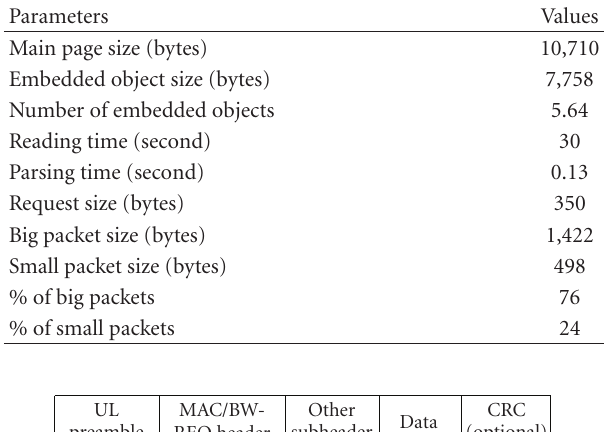
Table 7: Web workload characteristics.